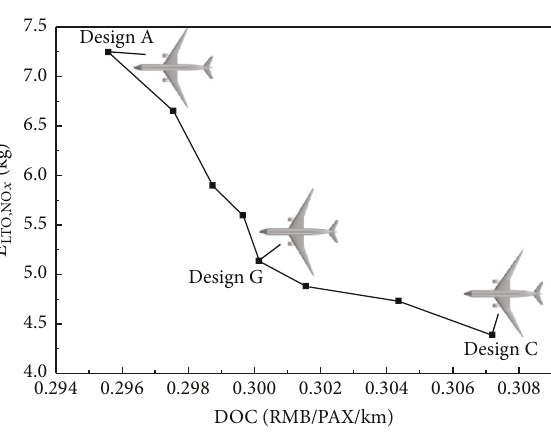
. Figure 13: Pareto front for minimum DOC and 𝐸 total